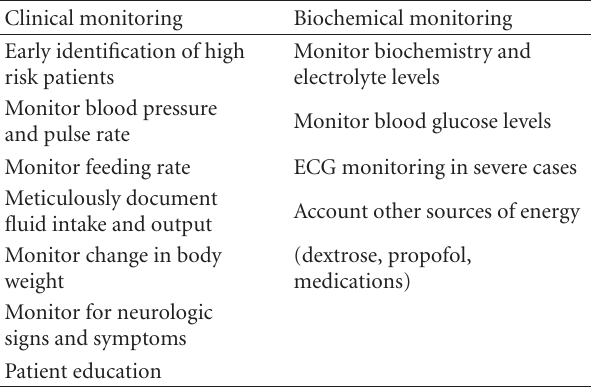
Table 3: Monitoring patients at risk of developing RFS [5, 6, 8, 30]. Clinical